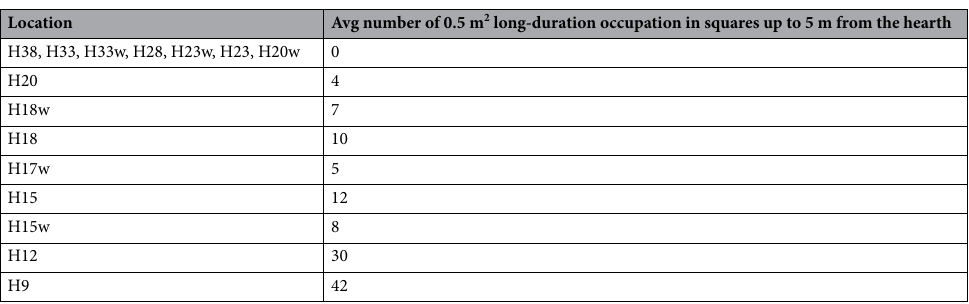
Table 4. Average long-duration occupation size with warmth effect.